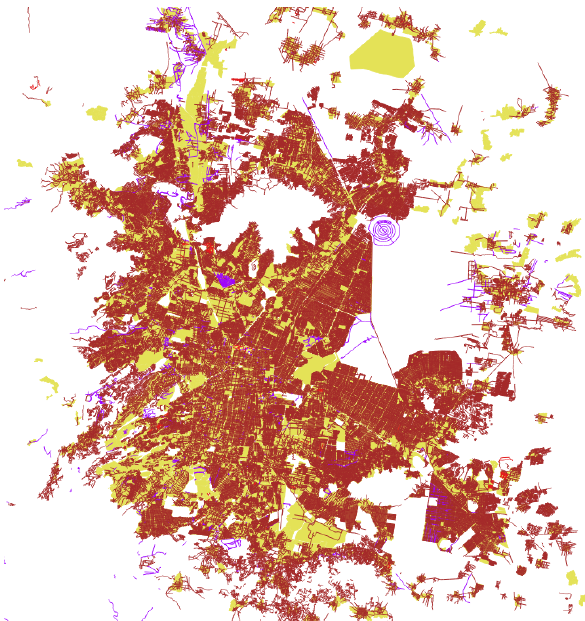
Figure 5. Residential roads of Mexico City (OSM: dark red = “residential”, red = “living street”, violet = “unclassified”; urban-area layer: light green)